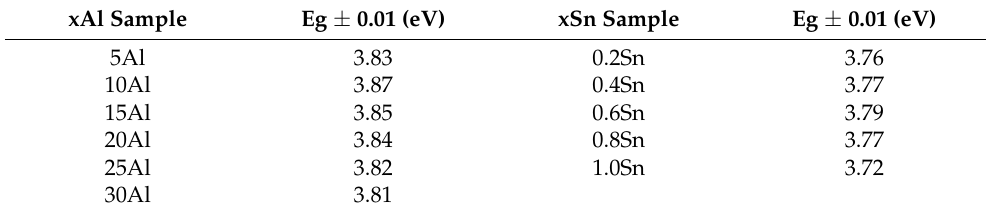
Table 1. Optical band gap of the